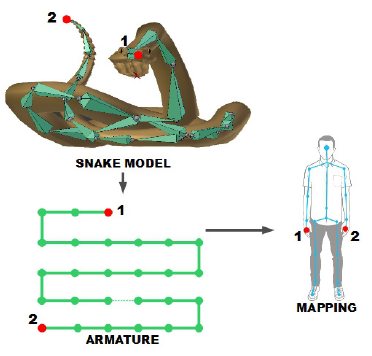
Figure 7. Mapping of the human skeleton onto the armature used to animate a seagull model(a video is available at http:// youtu.be/KL55NuRKQAk ).